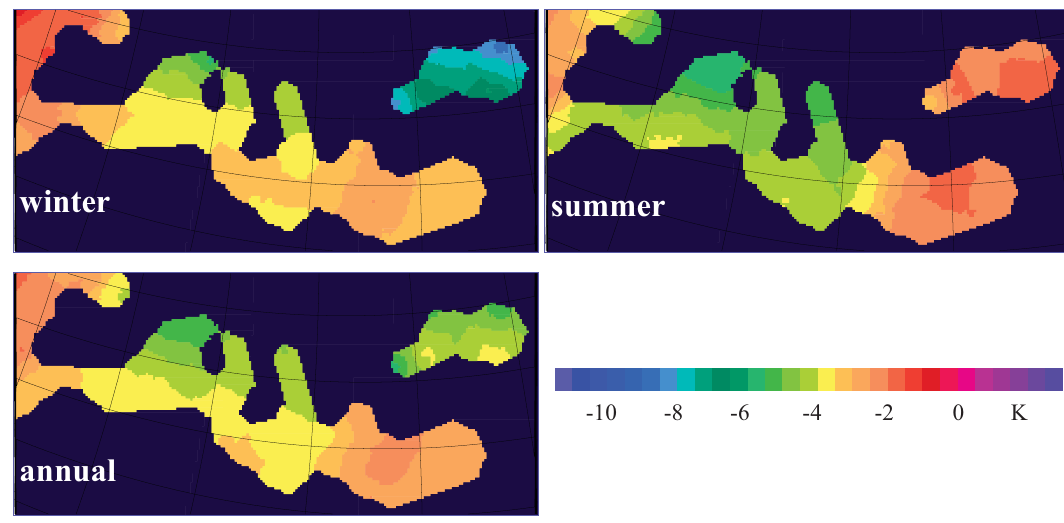
Fig. 15. Simuated SST anomalies LGM-CTL from the ESM in K. Winter (JFM), annual, and summer (JAS). The data have been interpolated onto the grid of the regional model. Cf. Fig. 9. The land sea mask has been interpolated from the ocean component of the ESM.